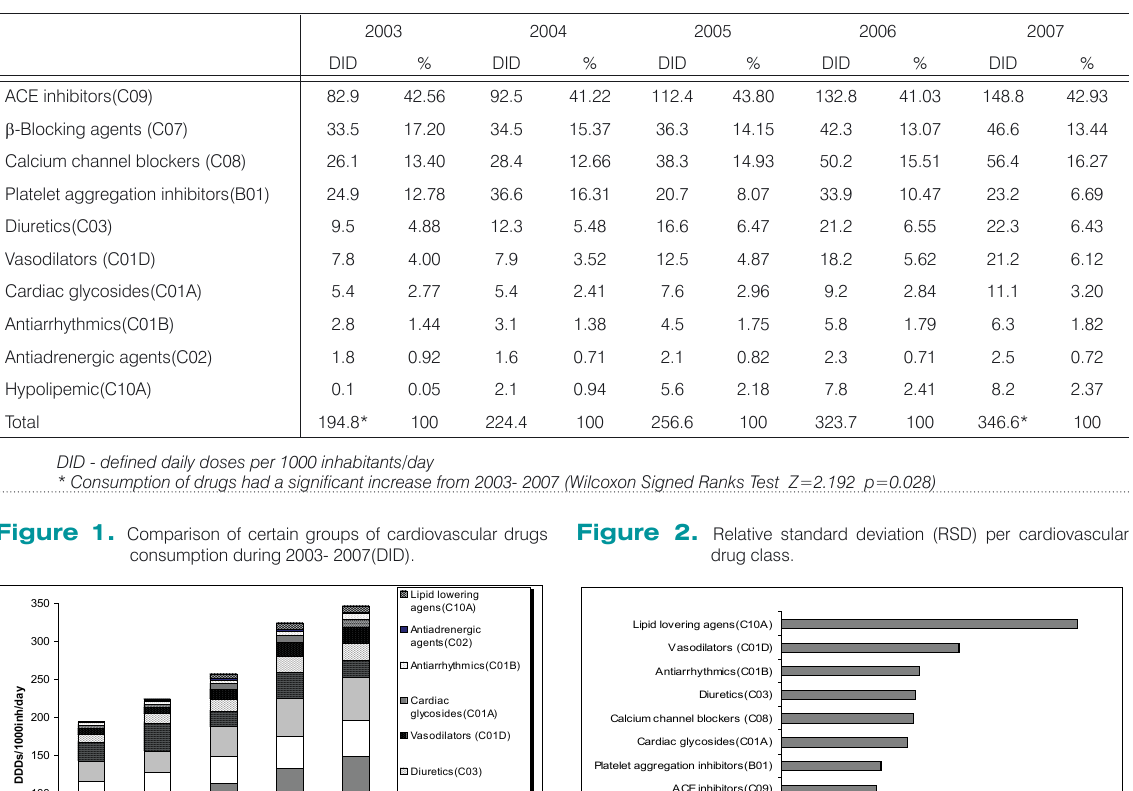
Table 1. Comparison of certain groups of cardiovascular drugs consumption during 2003- 2007.